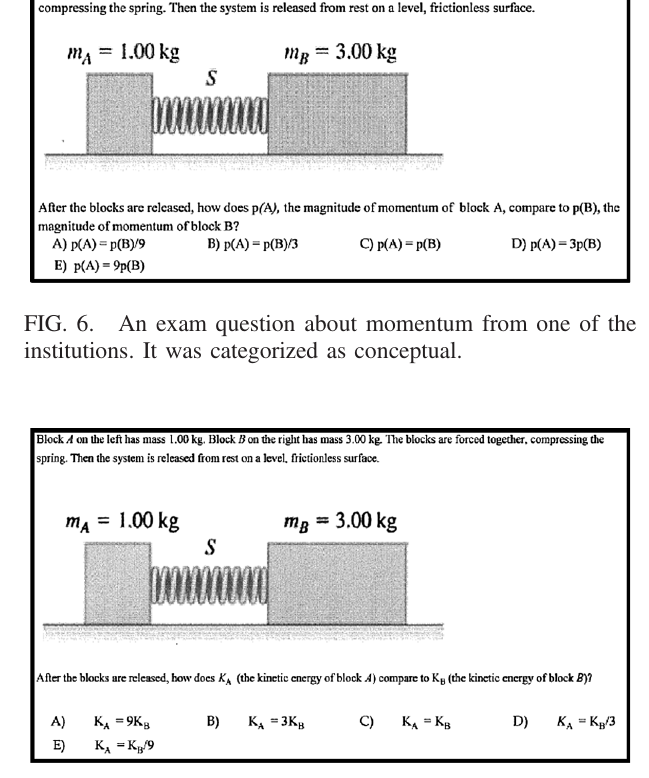
FIG. 7. An exam question about momentum from one of the institutions. It was categorized as calculational.